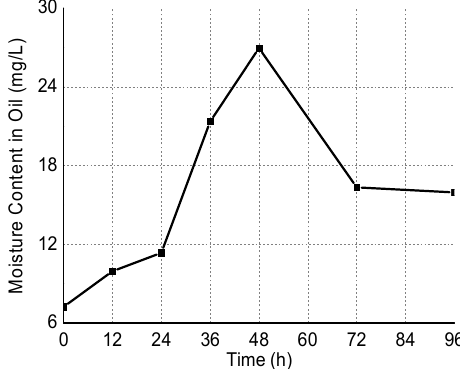
Figure 5. Change of moisture content in oil.